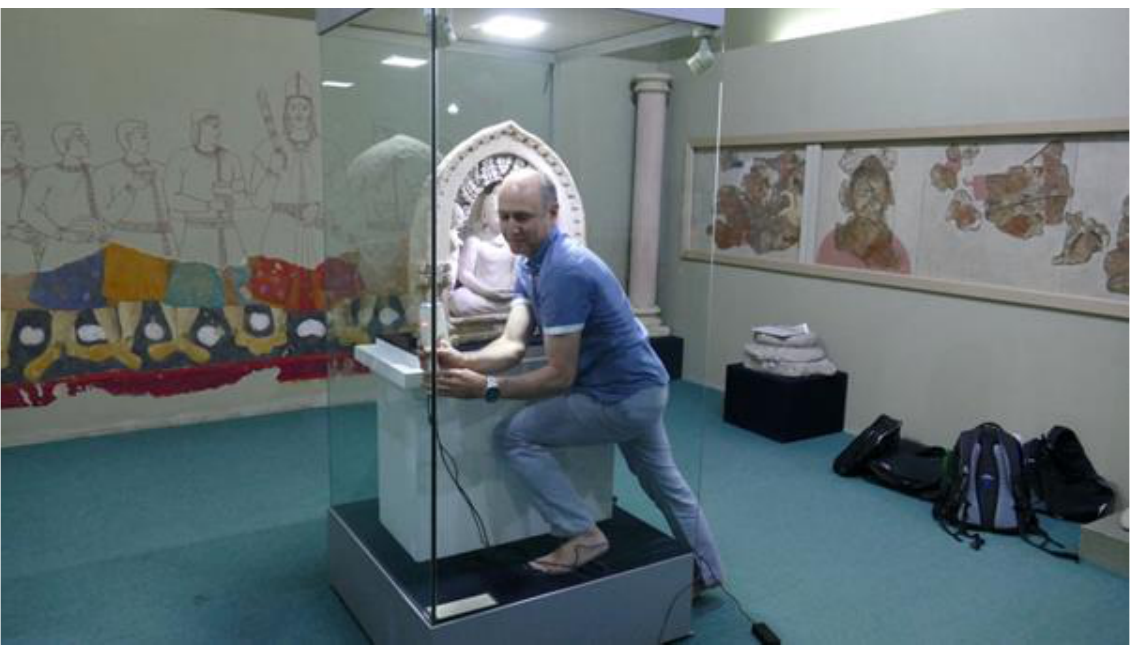
Figure 6. Scanning environment arrangement for scan the “Buddha” statue.